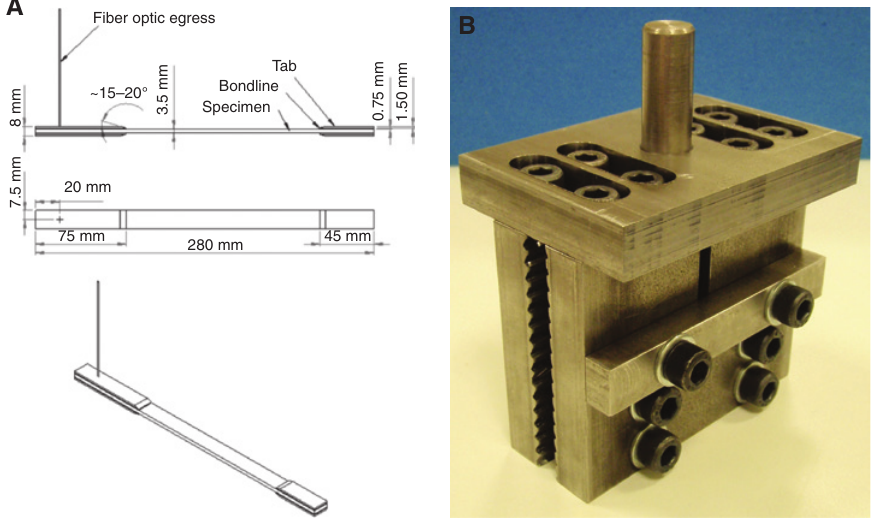
Figure 3: Drawing of test specimens (A) and gripping fixture